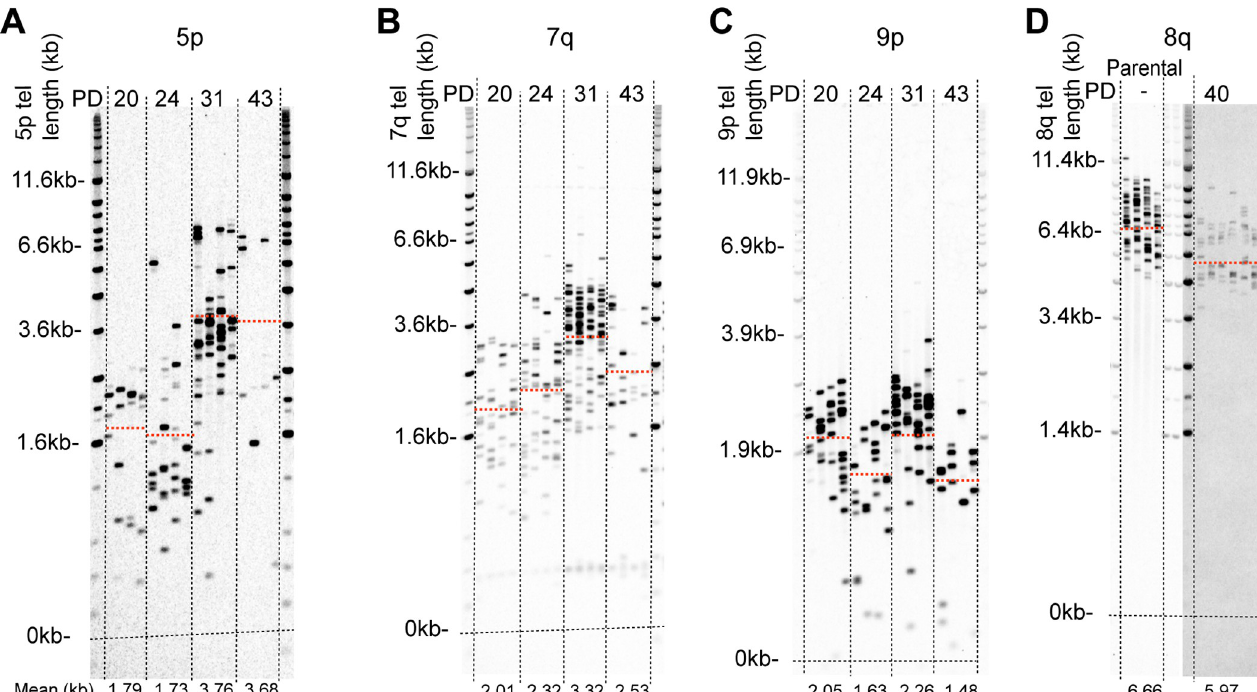
Fig 4. Chromosome specific elongation of short telomeres upon ALT upregulation in HCT116 epithelial cells. STELA profiles at the (A) 5p, (B) 7q, (C) 9p and (D) 8q chromosome ends for HCT116 ATRX-/o:DN-hTERT ALT-like clone 3 alongside the HCT116 ATRX-/o parental clone at the 8q chromosome end for reference with the PD indicated across the top and the mean telomere length indicated in kb across the bottom and also represented as orange dotted lines on the blot.